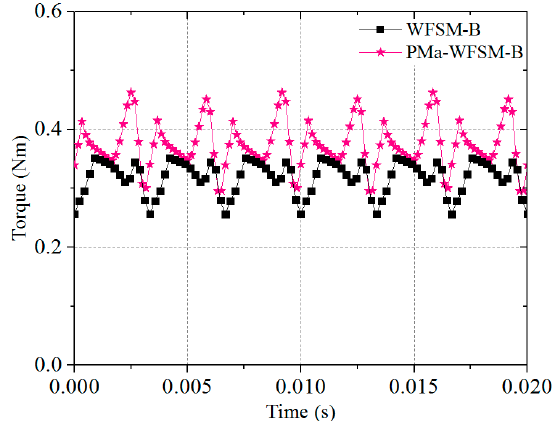
Figure 7. The electromagnetic torques. Table 2. Analysis results of basic model and proposed